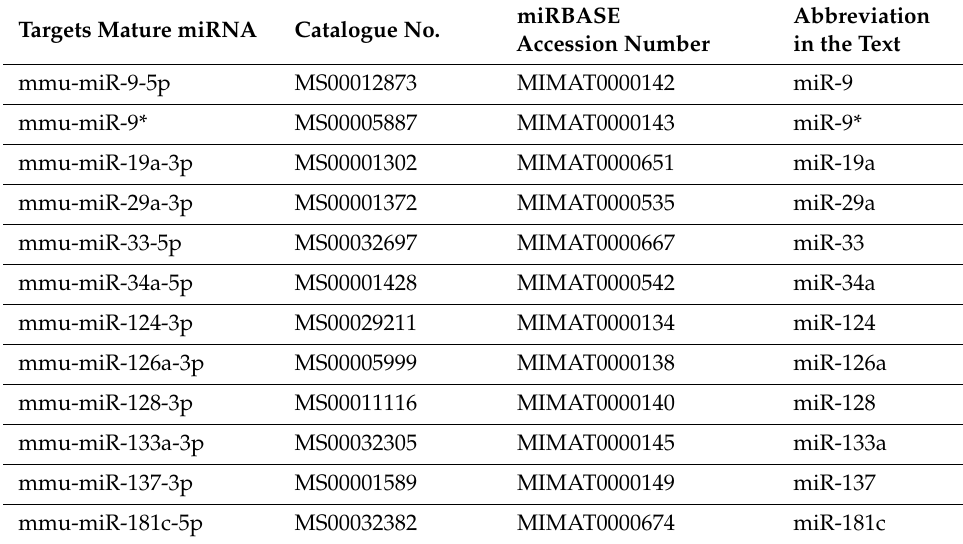
Table 3. miScript Primer Assays